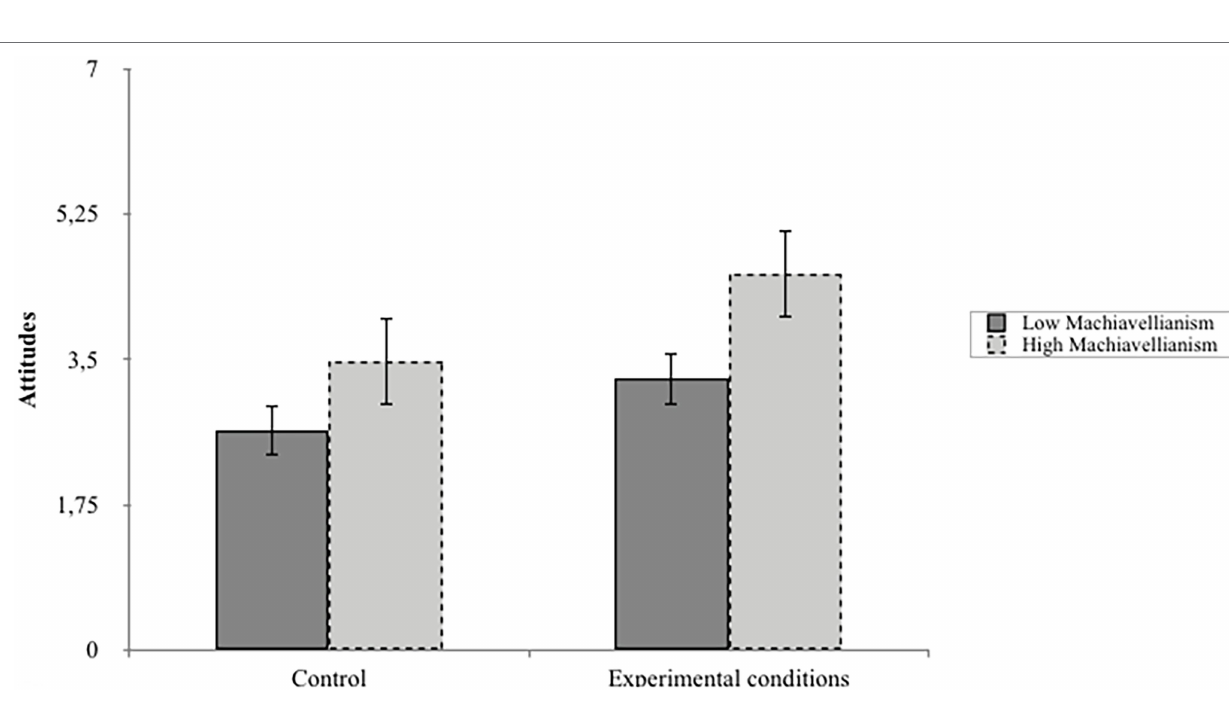
FIGURE 2 | The moderating role of Machiavellianism by narrative exposure on Attitudes about the